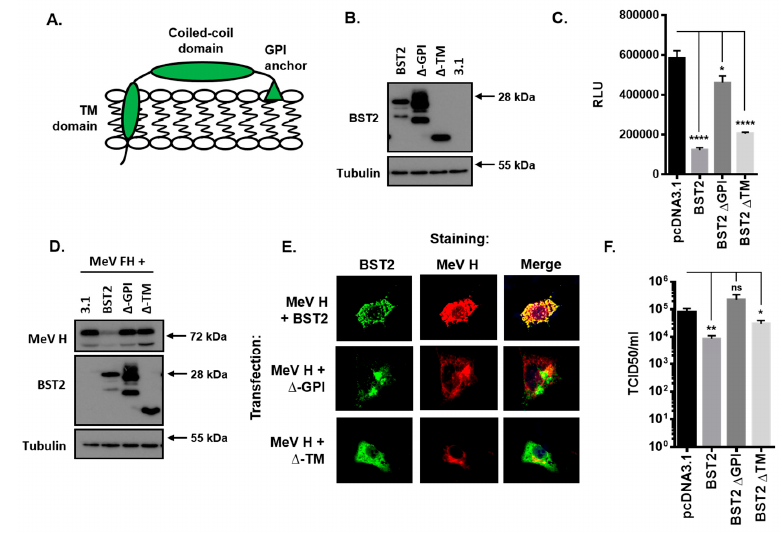
Figure 4. The BST2 GPI anchor is required for restriction of MeV replication. ( A ) The human BST2 protein is a membrane anchored protein composed of various domains (TM, transmembrane; GPI, glycosyl-phosphatidylinositol). ( B/D ) 293-hSLAMs transfected with pcDNA3.1, BST2, ∆ -GPI, or ∆ -TM were cotransfected with either 500 ng of pcDNA3.1 ( B ) or 250 ng each of pcDNA3.1-MeV F and H ( D ) and analyzed by western blot. The total mass of transfected DNA remained constant. ( C ) The HEK293T MeV effector cells were cotransfected with the indicated pcDNA3.1-based expression constructs and cell fusion quantified by assaying Renilla luciferase activity 16 h after co-culturing with hSLAMF1-positive target cells. ( E ) The Vero-hSLAM cells, cotransfected with the indicated pcDNA3.1-based expression constructs, and analyzed by immunofluorescence microscopy. Representative micrographs are shown together with merged images to demonstrate colocalization of labeled proteins. ( F ) 293-hSLAMs, transfected with the indicated pcDNA3.1-based expression construct for 24 h, were infected with MeV-GFP and total virus replication assayed at 72 h. Error bars indicate standard deviation (F) or error (C) of the mean. Statistical significance is as follows: *, p < 0.05; **, p < 0.005; ****, p < 0.0001.